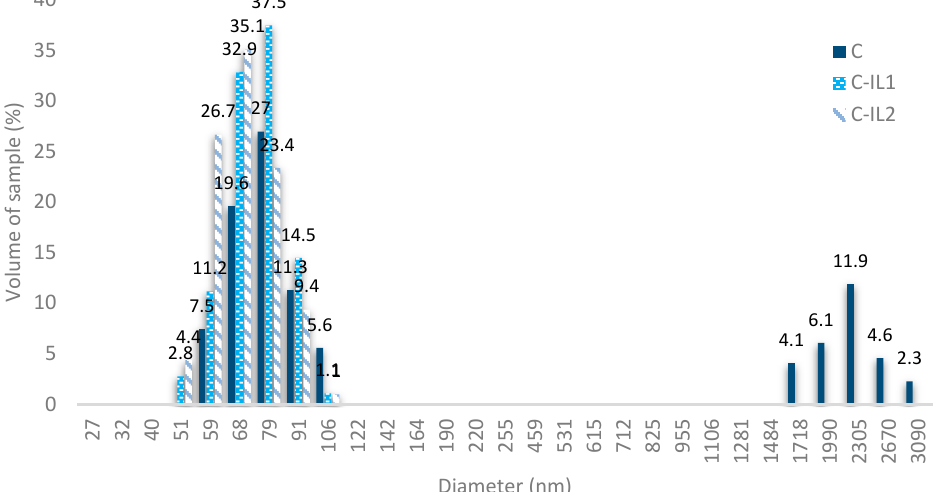
Figure 3. The particle size distribution of nanocellulose treated by enzymatic hydrolysis (C) and after functionalization with ionic liquids.